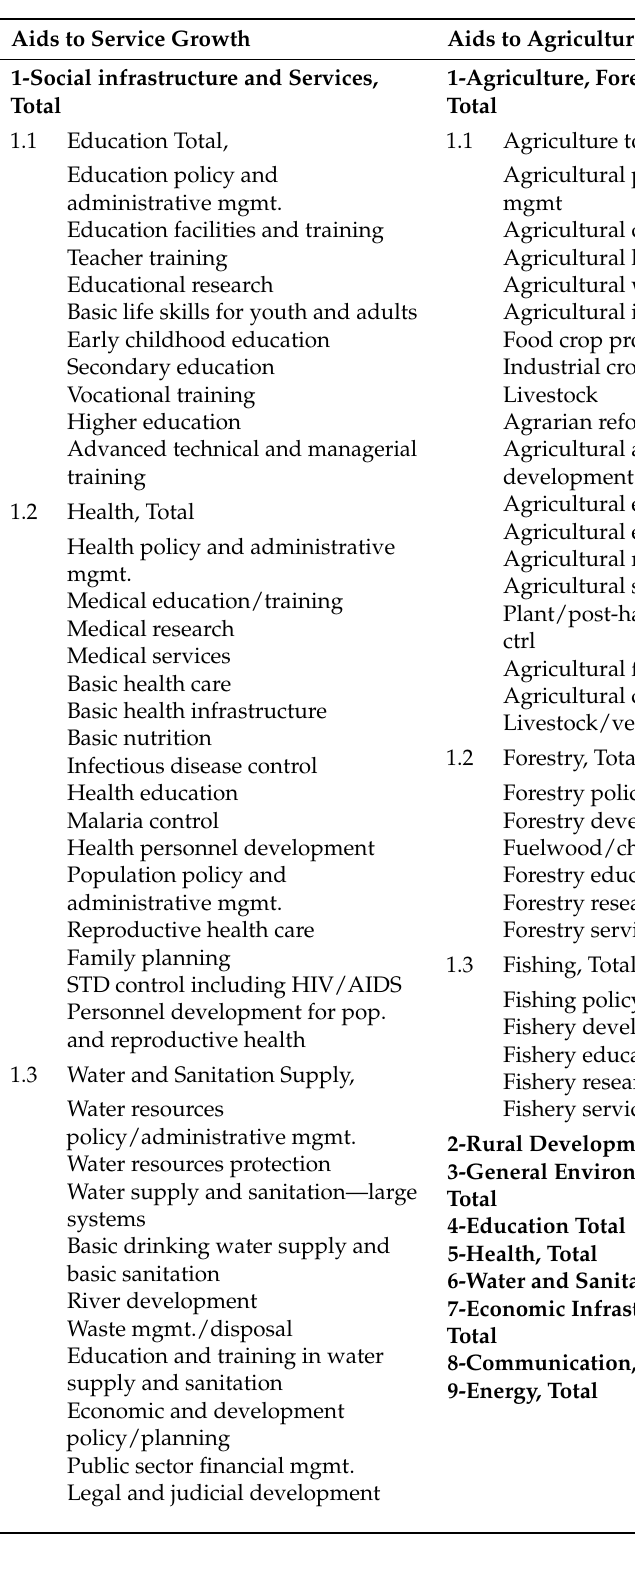
Table A1. List of Aid Categories Used to Construct the Allocated Sectoral-Aids